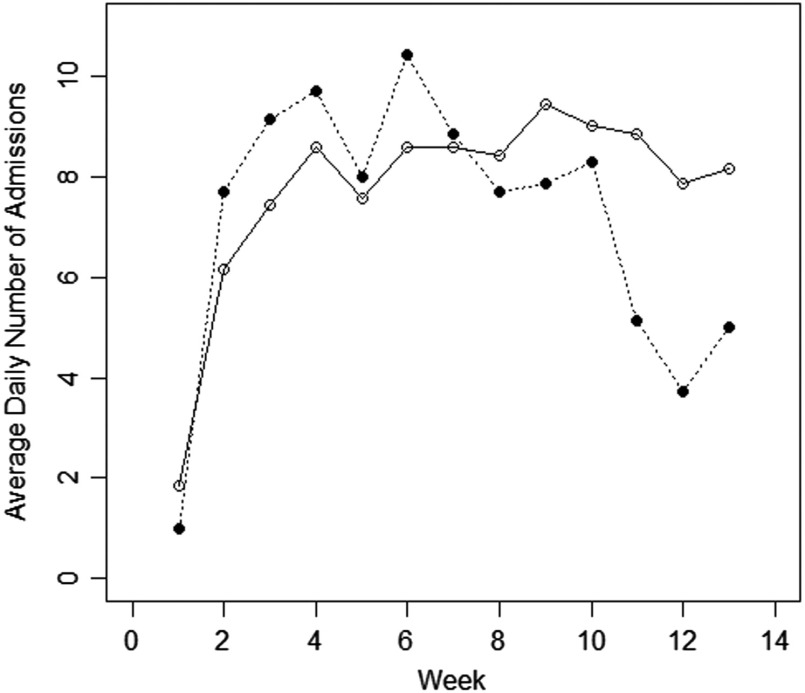
Average daily number of admissions to seven GHPWs in 13 weeks from January 1, 2019, to 31 March, 2019 (solid lines) and in the corresponding weeks from January 1, 2020, to March 31, 2020 (dotted lines).